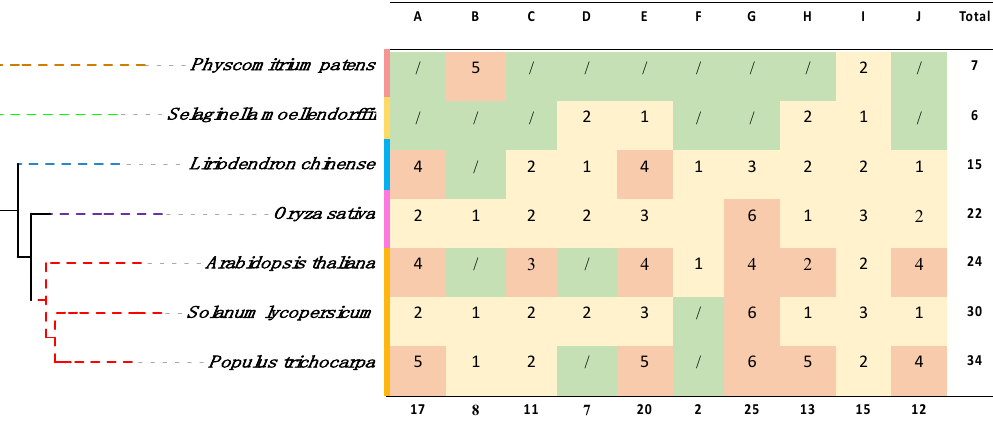
Figure 2. TCP gene family, Phylogenetic tree analysis of 6 different plant species. ( A ) The phyloge- netic tree was constructed from 138 TCP protein sequences. Sequences were aligned using Mega 11 software, and a bootstrap value of 1000 was set as repetition with other default parameters. The key indicates that different color shapes represent different groups and taxon names. ( B ) The interspecies phylogenetic tree was constructed using the iTOL online tool from orthologs found by Xshell software. ( C ) Summary of the phylogenetic tree classification, the various groups are denoted in alphabetic letters (A–J). Varying color schemes represent the total numbers of individual plant species within a specific group.